Question: Which kind of chart has been used to present this data?
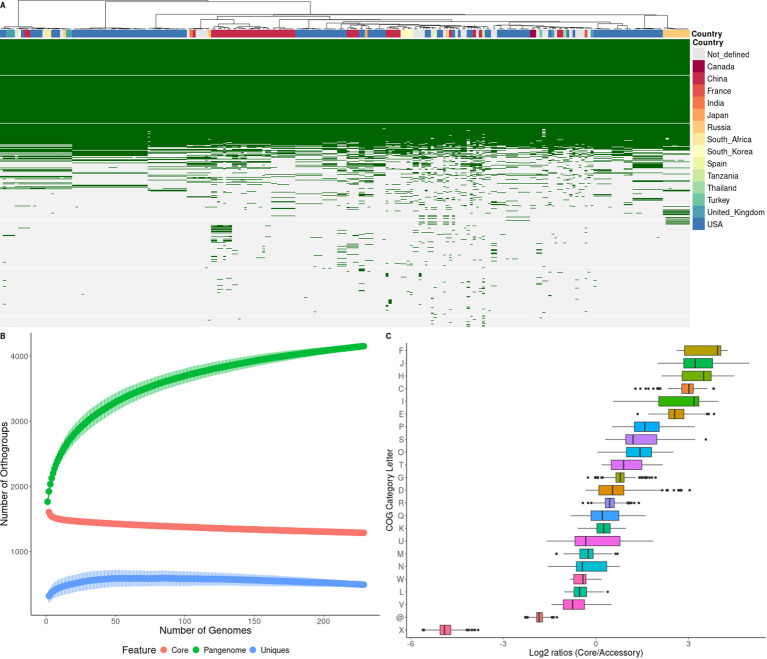
Answer: heatmap